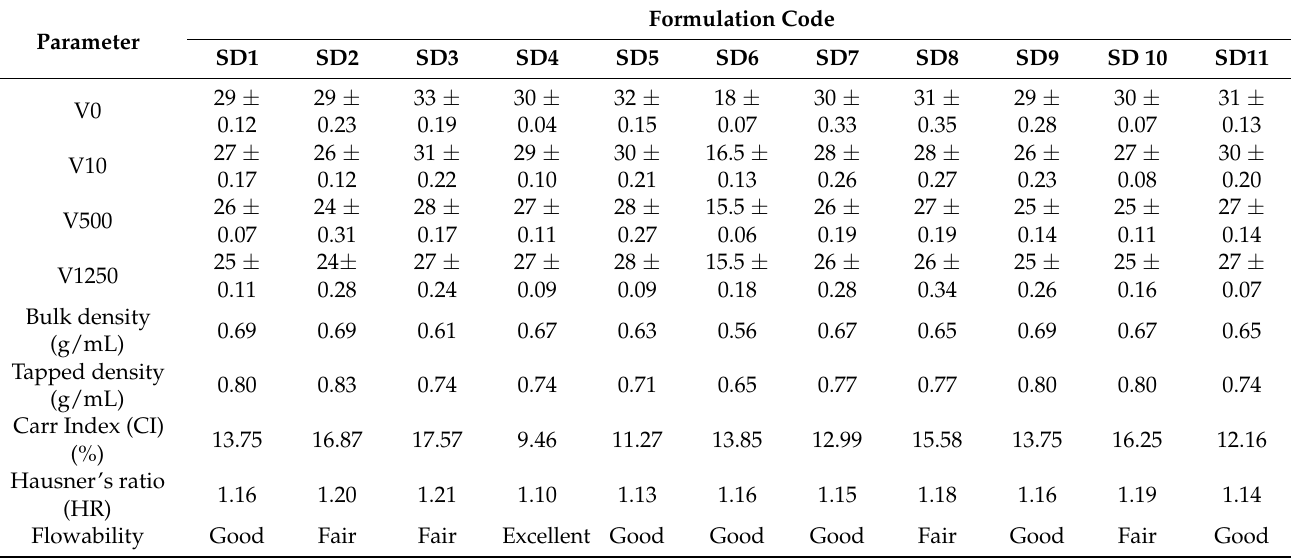
Table 4. Volumetric characteristics for the hot-melt extrusion SD.